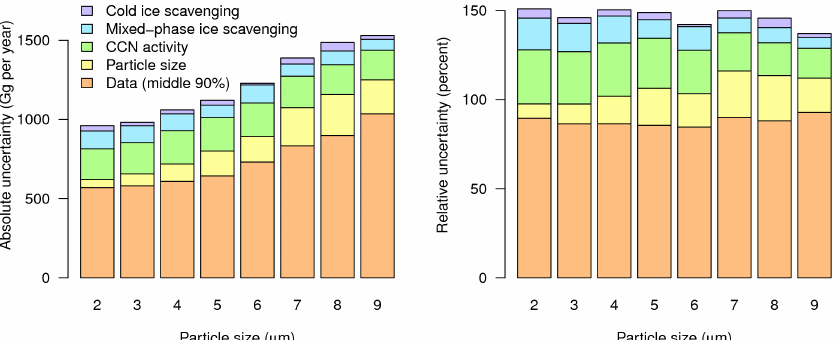
Fig. 6. Top: model and observation uncertainty in the inferred mean global flux (median per uncertainty type for various cases), expressed as absolute uncertainty. Bottom: Same, expressed as a relative uncertainty, i.e. (absolute uncertainty in global flux estimate)/(median global flux estimate) · 100 . The sum of the individual uncertainties exceeds the value of the median global flux estimate in each case, resulting in relative uncertainties that exceed 100%. The color key is indicated in the left panel.